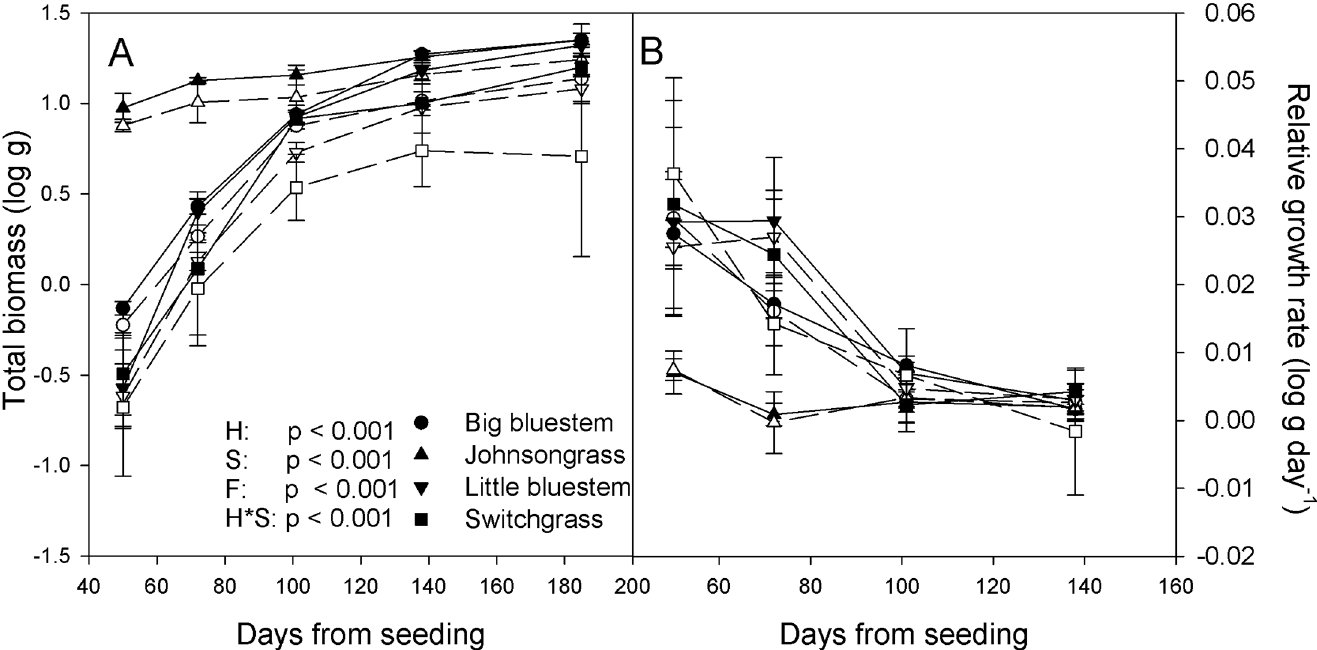
Fig 1. Growth dynamics of the four study species grown as single plants. A: Log of total biomass over five harvest dates. Shownin the panel are the p-values of all statisticallysignificanteffects, includingharvest date (H), species (S), fertilizer (F) and a harvest date x species interaction (H * S). B: Relativegrowth rates for the interval betweentwo consecutiveharvests, standardized to a daily relative growth rate. Solid symbols for the higherfertilizer level, open symbols for the lower level. Error bars reflect one standard error of the mean.